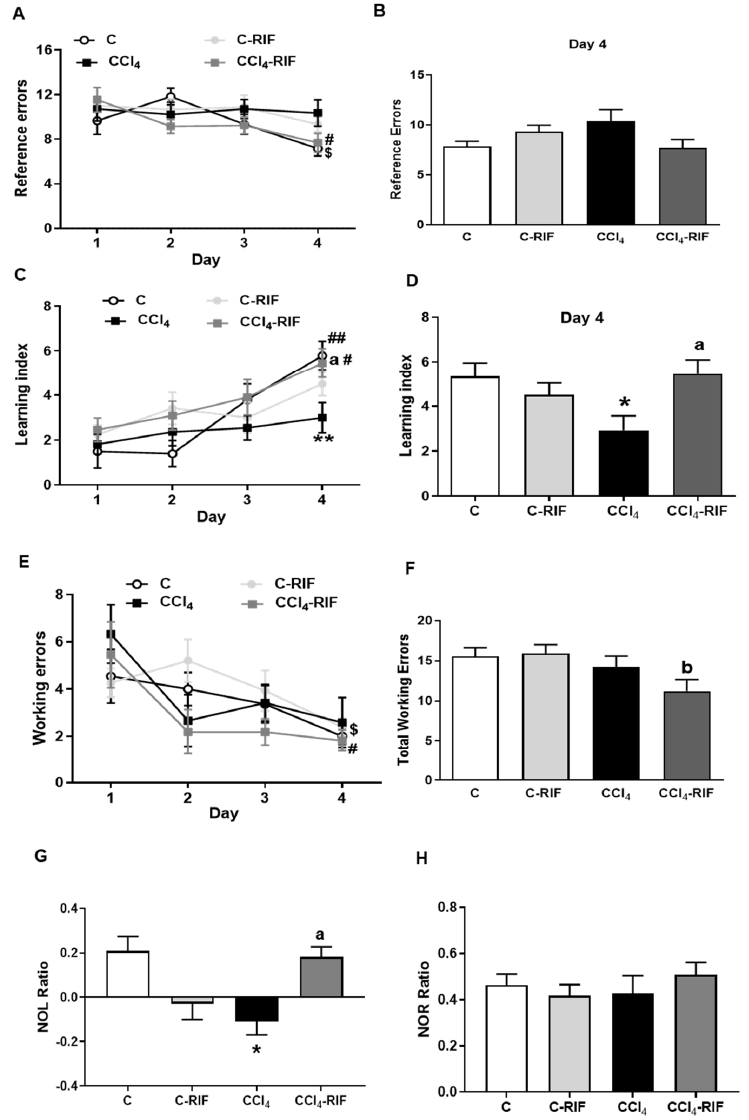
Figure 5. Spatial learning and reference and working memory in the radial maze and novel object location (NOL) and recognition (NOR) memory tests. Reference memory ( A , B ) spatial learning ( C , D ), and working memory ( E , F ) were evaluated in the radial maze. Values are the mean ± SEM of 15 rats per group. In ( A , C , E ) the data were analyzed using a two-way ANOVA with repeated measures and Tukey’s multiple comparison test. In ( A ), only for time a significant effect was found (F (2.856, 142.8) = 4.332, p < 0.01); in ( C )the effect between groups was significant (F (3, 40) = 2.925, p < 0.05) as well as the time effect (F (2.949, 118.0) = 13.69, p < 0.0001); in ( E ), only the time was significant (F (3, 72) = 4.24, p < 0.01). In B and F non-parametric Kruskal–Wallis test and Dunn’s multiple comparisons test was used and no significant effects were found. In ( D ) one-way ANOVA and Tukey’s multiple comparisons test was used and statistic value was F (3, 45) = 3.789, p < 0.05. In multiple comparisons, the asterisks indicate a significant difference with respect to the control group * p < 0.05, ** p < 0.01, “a” with respect to CCl 4 rats “a” p < 0.05 and “b” compared with C-RIF group, “b”, p < 0.05. The symbol # indicates within the same group significant difference with respect to day 1 “#” p < 0.05 and “##” p < 0.01. The $ symbol indicates within the same group a significant difference with respect to day 2 “$” p < 0.05. Rats were evaluated for the ability to identify the change in location of an object through the NOL test ( G ) and to identify a new object by the NOR test ( H ).